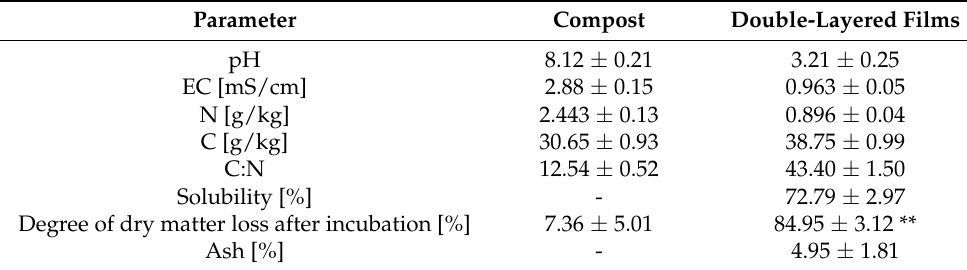
Table 1. Parameters of incubated